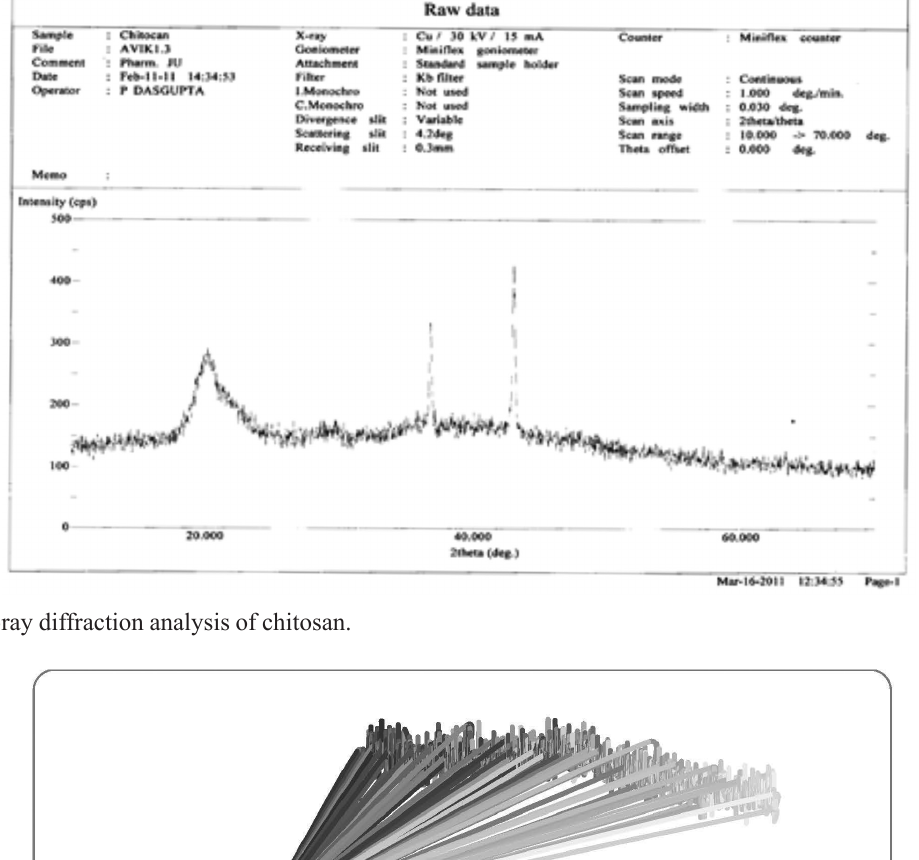
FIGURE 9 (d) - X-ray diffraction analysis of chitosan.